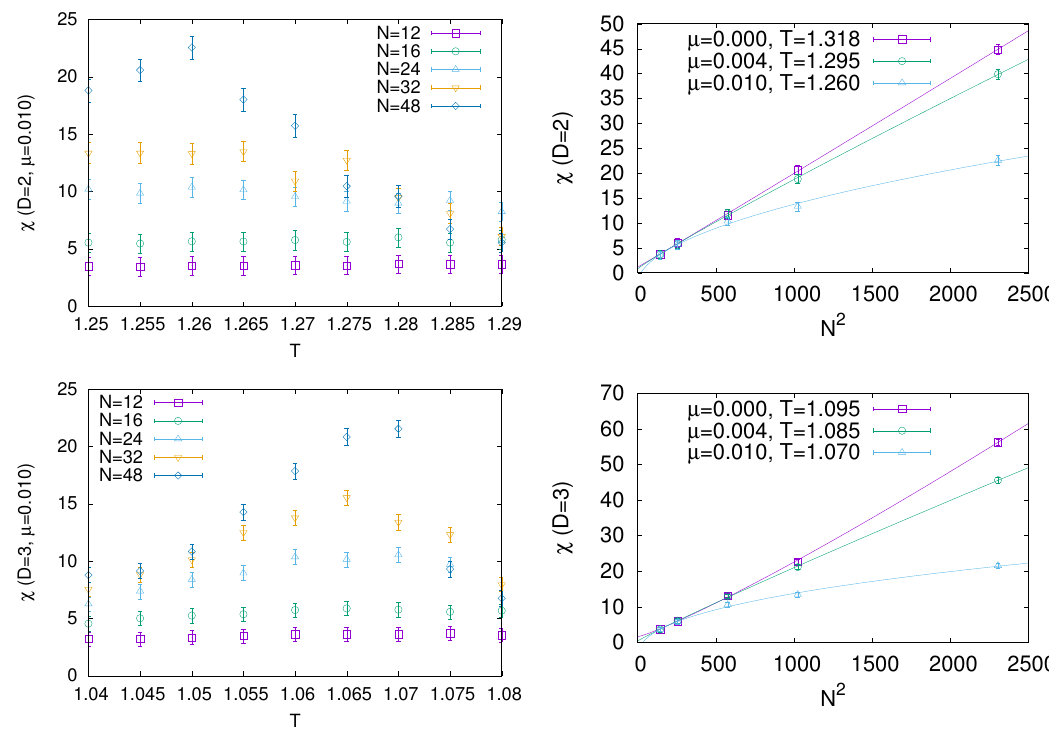
Figure 6 . Susceptibility (cid:31) for D = 2 (top) and D = 3 (bottom), against T for (cid:22) = 0 : 010 (left) and against N 2 (right), the latter being (cid:12)tted with (cid:31) = (cid:13)N 2 p + c . This (cid:12)tting turns out to work only at low temperature, but this bolsters that the system undergoes a third-order phase transition at low